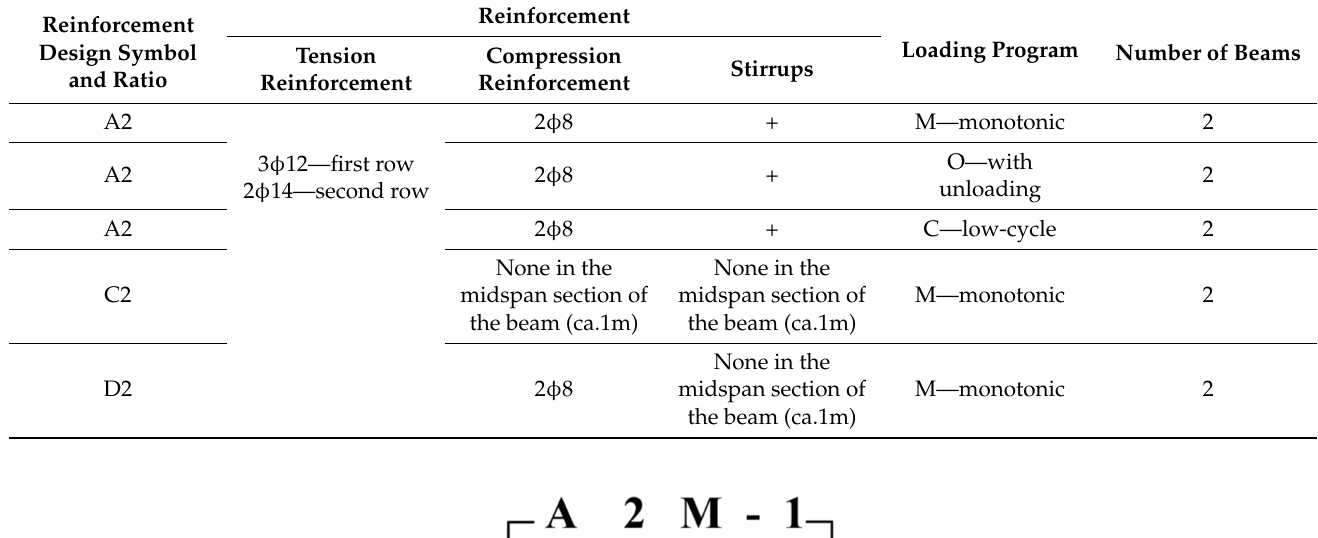
Table 1. Summary of beam data.